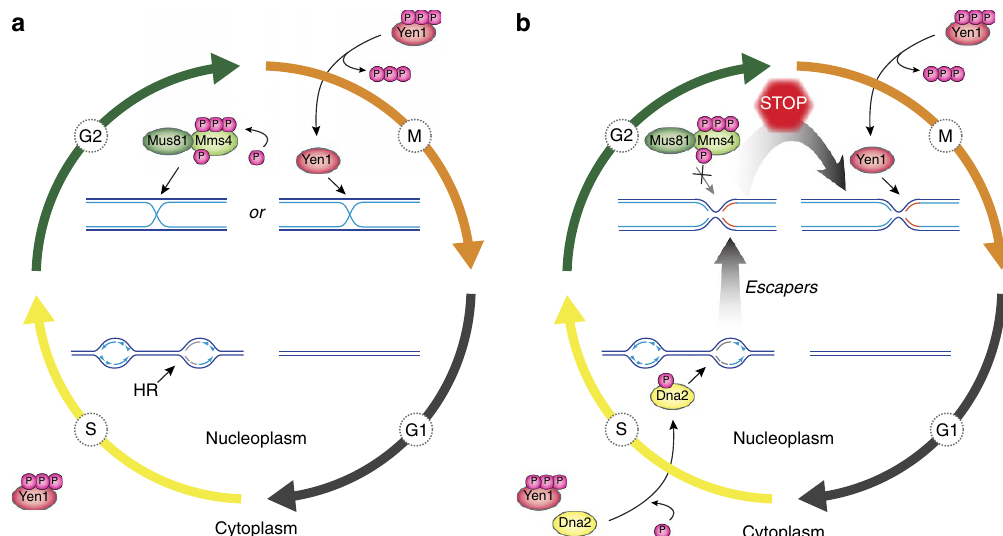
Figure 7 | Model for a two-tiered response to replication stress by Dna2 and Yen1. ( a ) Canonical role of Yen1 in the resolution of HR intermediates that arise during HR-mediated recovery of stalled replication forks. Mus81-Mms4 is activated by hyperphosphorylation in G2/M, prior to activation and nuclear import of Yen1 upon anaphase onset. Thus, HR intermediates are predominantly cleaved by Mus81-Mms4, with Yen1 acting as a catchall in M phase to remove persistent recombination structures in time for chromosome segregation. ( b ) Parallel to HR, the Dna2 helicase is tending to stalled replication forks. Replication intermediates that escape the attention of Dna2 give rise to toxic structures that are sensed by the DNA damage checkpoint, but which are refractory to processing by Mus81-Mms4. At anaphase entry, Yen1 is activated and uniquely resolves persistent replication intermediates, averting mitotic catastrophe. See text for